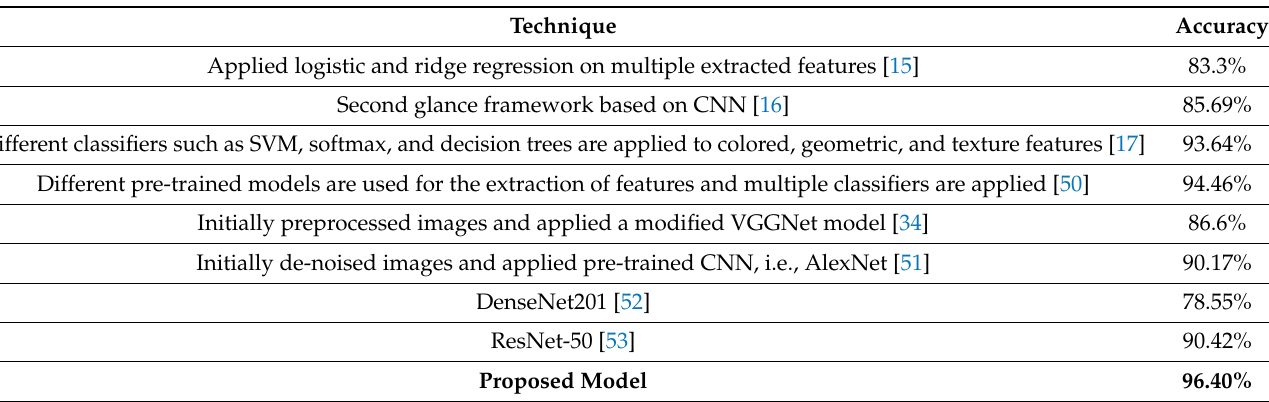
Table 9. Performance comparison with the state-of-the-art